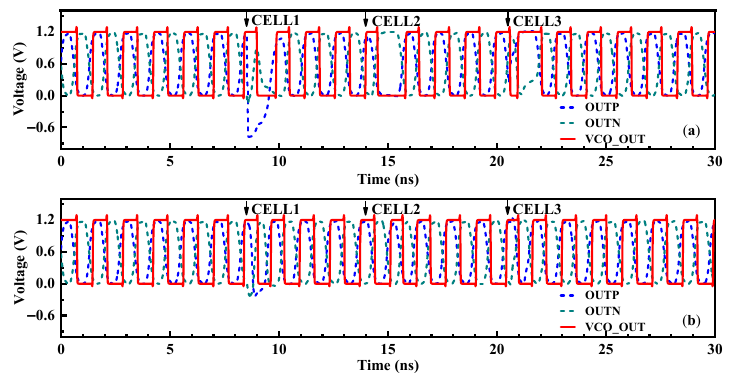
Figure 10. Simulation results of the phase noise of the VCO before and after hardening.